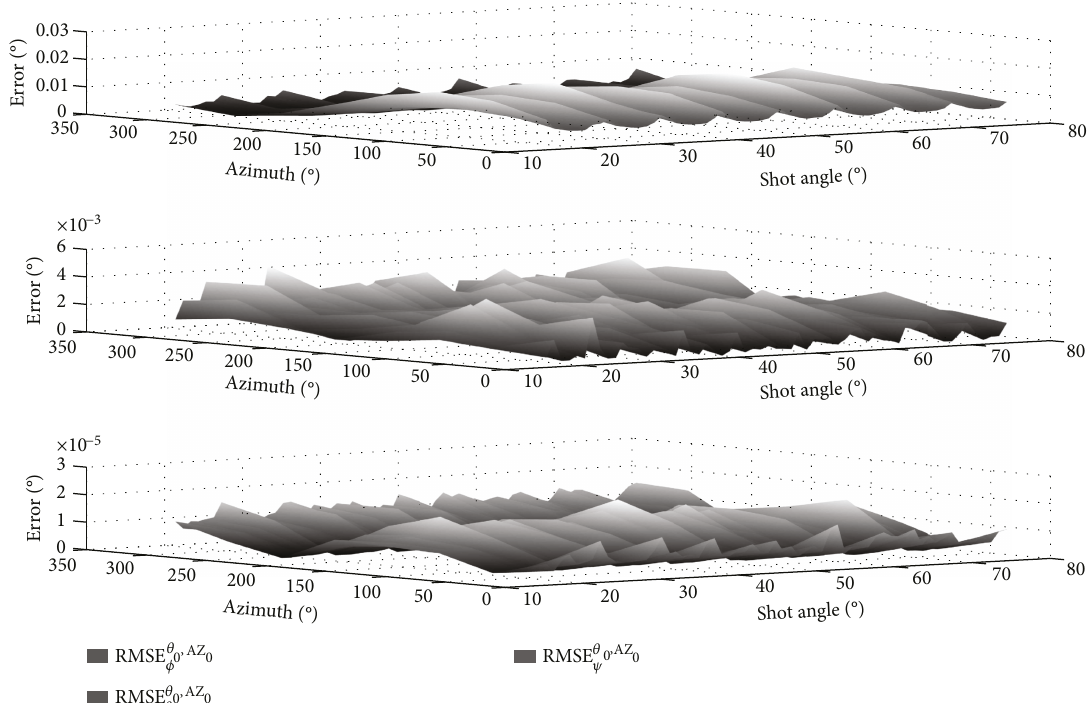
Figure 5: Representation of Euler angle RMSE along the whole trajectory for each shot angle and for the 8 azimuths